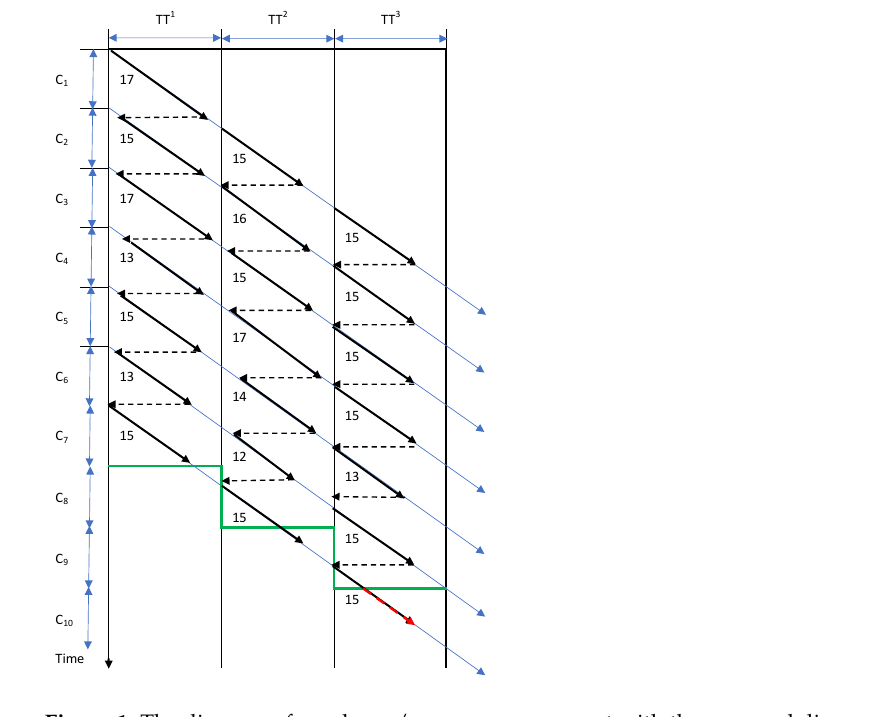
Figure 1. The diagram of employee/conveyor movement with the assumed disassembly cycle time C = 15, travel cycle time TT = 25 and real disassembly cycle times (12–17). The disassembly time of the seven products is only one minute longer for the con- veyor transport time between disassembly stations, TT s = 15 min and for the same differ- ences between the assumed and real cycle times (Figure 2). Conveyor transport is per- formed manually, and travel time is equal to the disassembly cycle time.